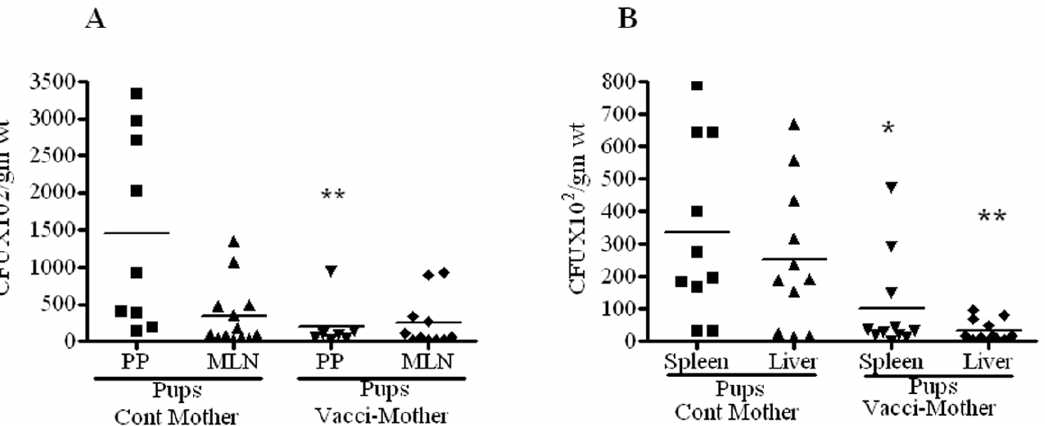
Figure 3. Pre-pregnancy vaccination of mice reduces bacterial burden in pups. Non- pregnant nice were given 3 doses of 10 4 cfu of vaccine strain at an interval of one week. A week after the last vaccination the mice were mated. The pups of vaccinated and unvaccinated mice were challenged with 10 7 cfu of WT bacteria and on the 5th day of post infection of pups (4 weeks), organ CFU of Spleen and Liver (A) and PP and MLN (B) was recorded. Data shows the representative of three independent experiments performed. * p , 0.05, ** p , 0.001 (Mann-Whitney test).